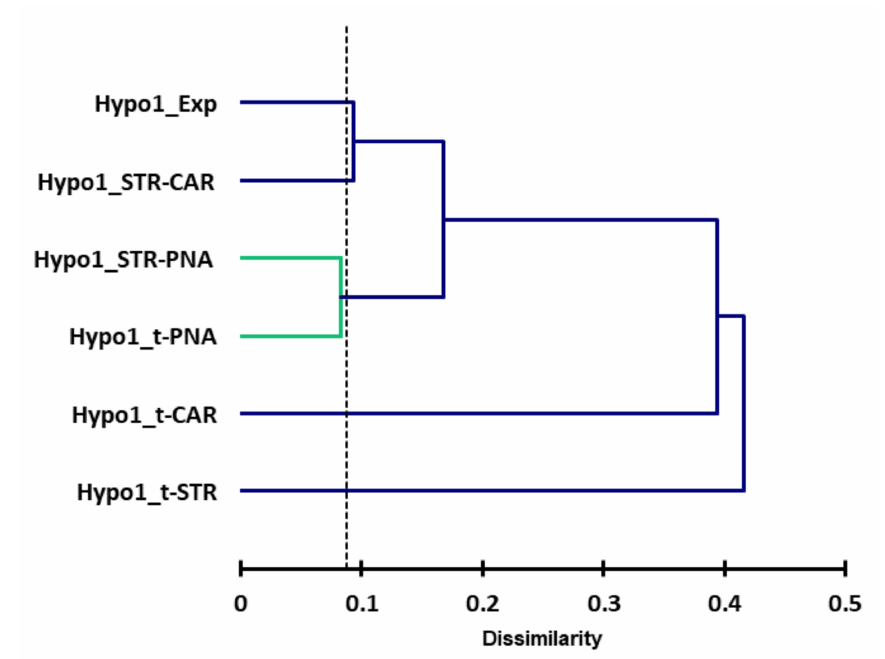
Figure 9. Dendrogram of the odorants obtained by cluster analysis for the ligand-based common feature hypothesis. The proximity matrix is reported in Table A1.